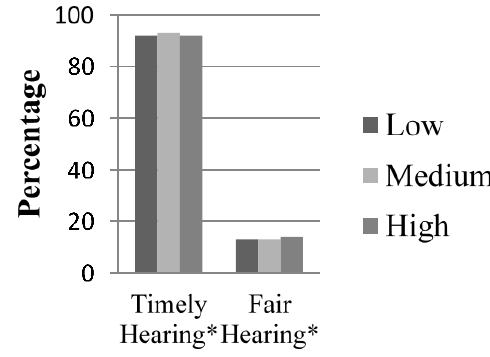
Figure 3. TennCare Appellate Hearings by Priority County. Soc. Sci. 2017 , 6 , 3